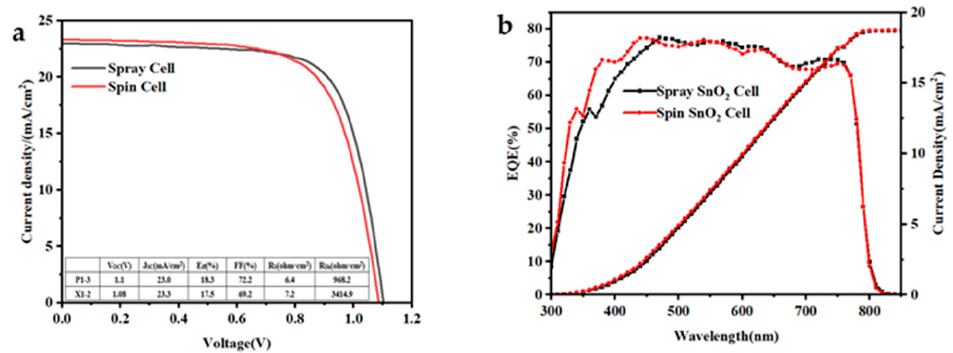
Figure 6. J–V ( a ) and EQE ( b ) curves of perovskite cell prepared based on sprayed and spin-coated SnO 2 film.